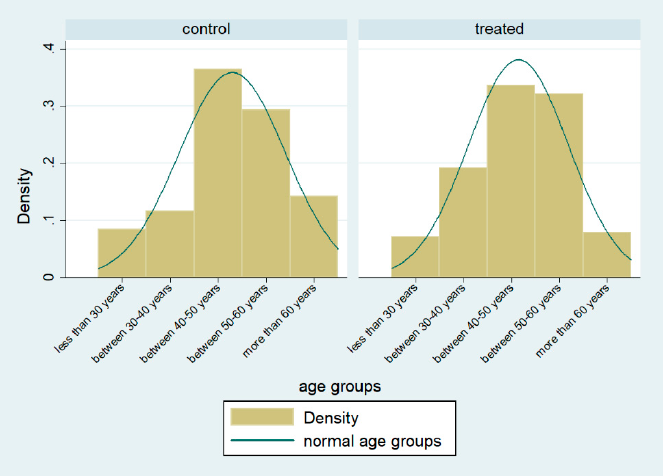
Figure 2. Percentage of age groups for treated and control groups . Source: Our elaborations on survey.